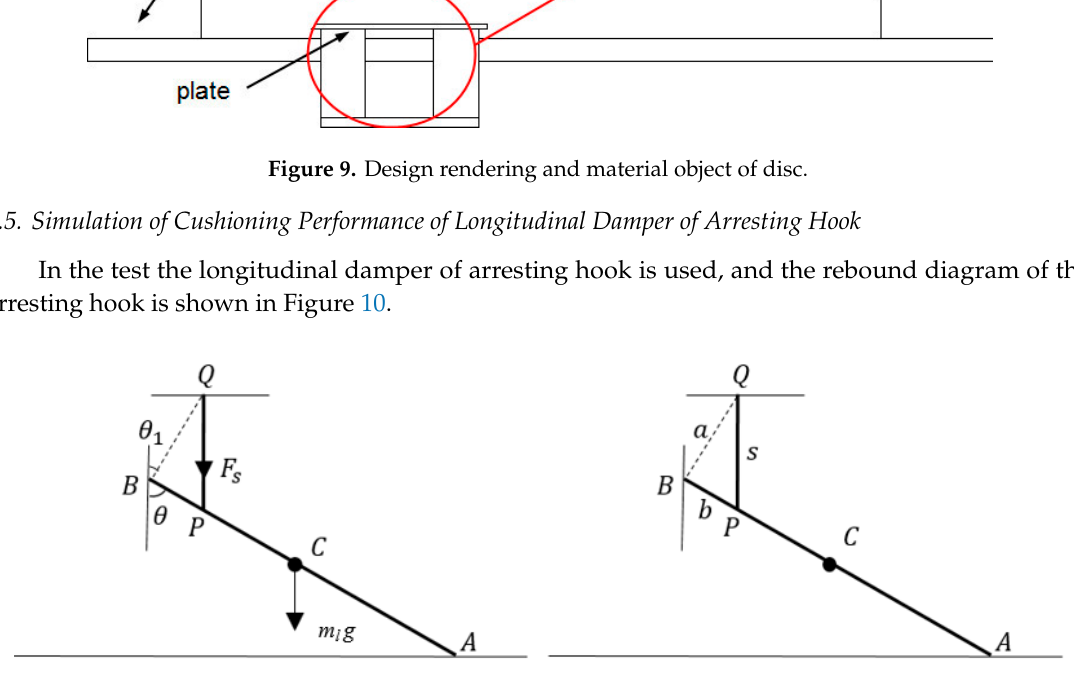
Figure 10. Rebound diagram of the arresting hook.